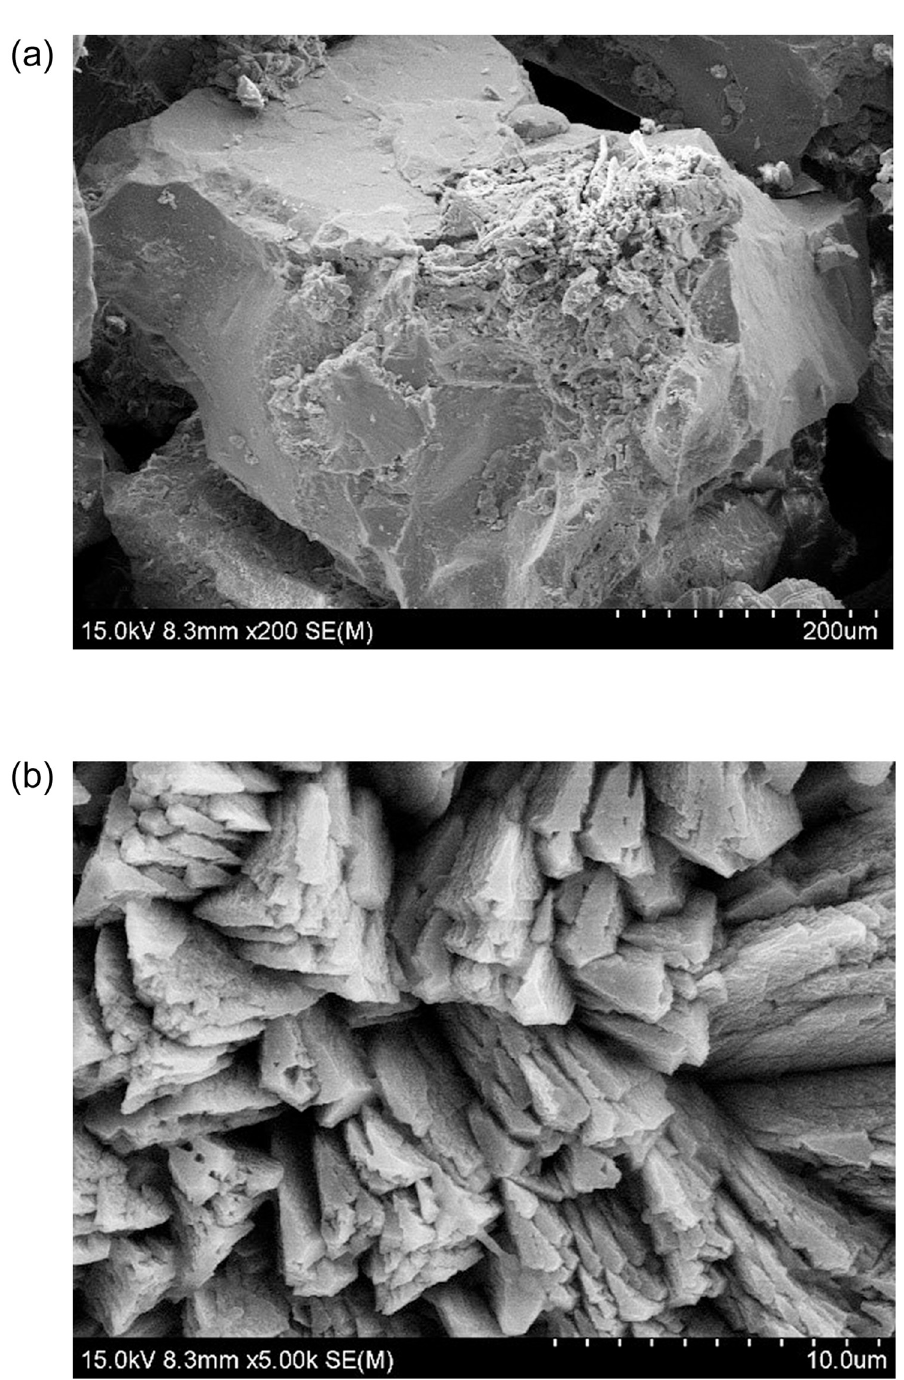
Fig 8. Morphology of quartz sand cemented calcite. (a): SEM at 200.0um;(b): SEM at 10.0 um.